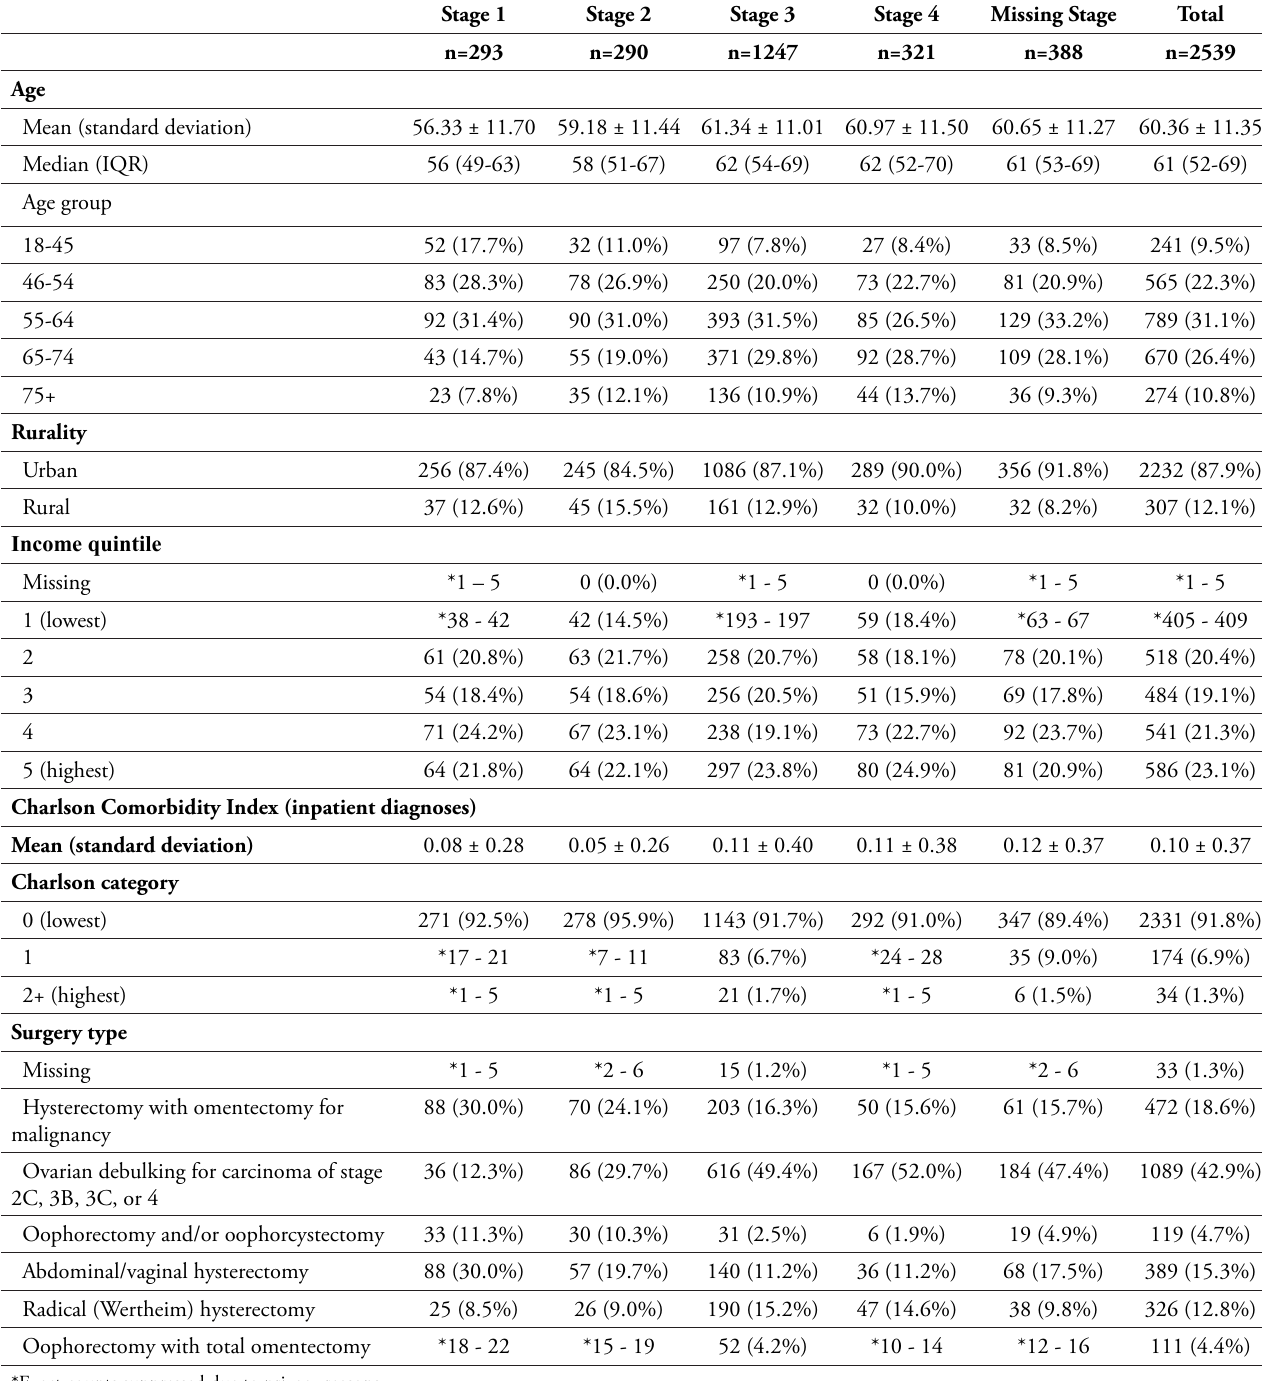
Table 1. Baseline Characteristics Stratified by